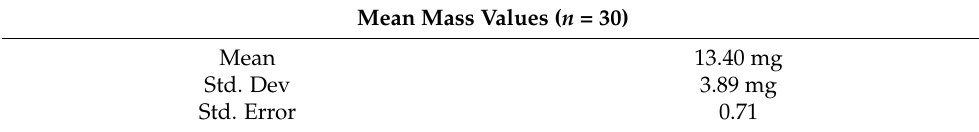
Table A3. Mean mass values of 30 tissue biopsy